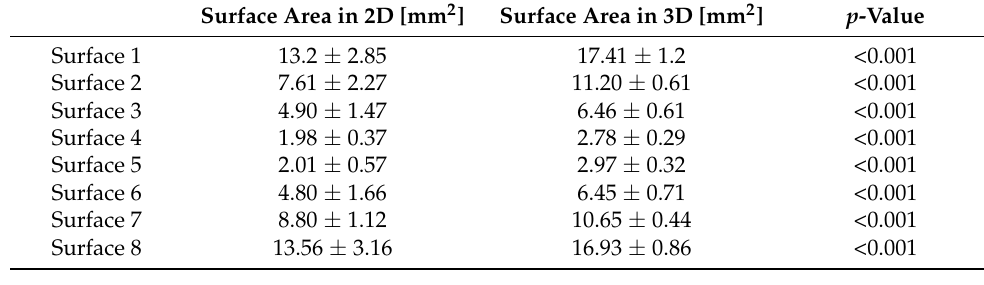
Table 1. Mean surface area and standard deviation for all 8 grinding surfaces over the 18 prepared splints measured from 2D photographs and 3D scans. p -values are reported for independent-samples t -test for differences between the measurement methods.